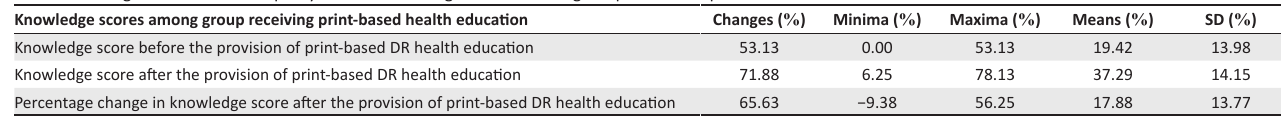
TABLE 3: Change in diabetic retinopathy related knowledge score following the provision of print-based health education. Knowledge scores among group receiving print-based health education Changes ( % ) Minima ( % ) Maxima ( % ) Means ( % ) SD ( % )